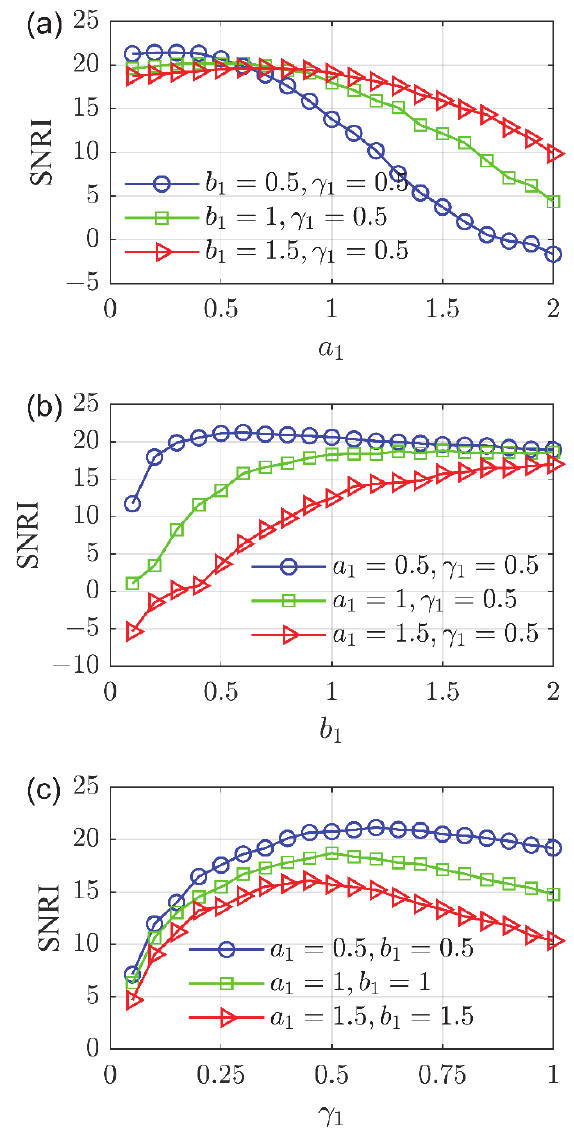
Figure 2. The input–output signal-to-noise ratio improvement (SNRI) of stochastic resonance (SR) system versus system parameters: ( a ) a 1 ; ( b ) b 1 ; ( c ) γ 1 .